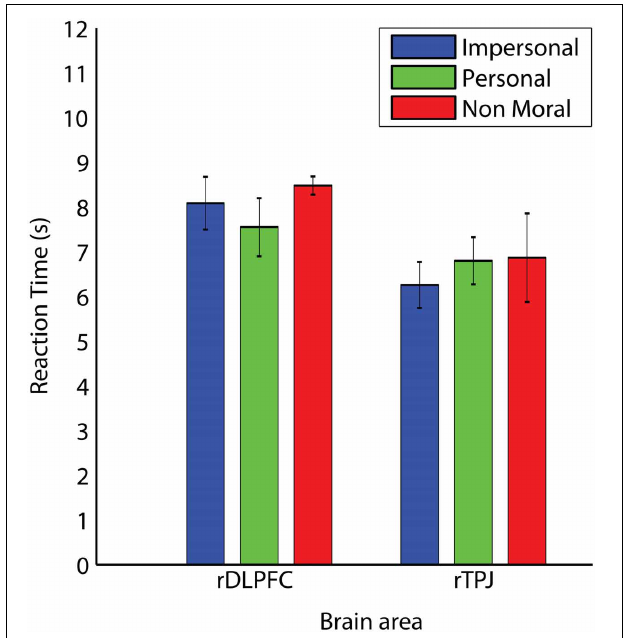
FIGURE 2 | Reaction times in TMS experiment. The three different moral conditions grouped over the four different time points of TMS application over the right DLPFC and right TPJ. Error bars indicate one standard error from the mean on both sides.